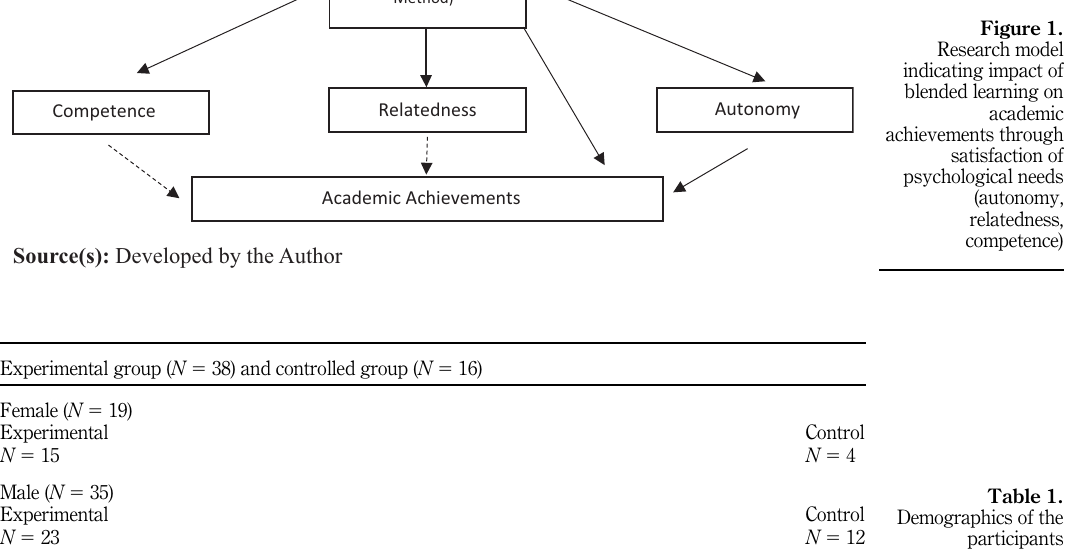
Figure 1. Research